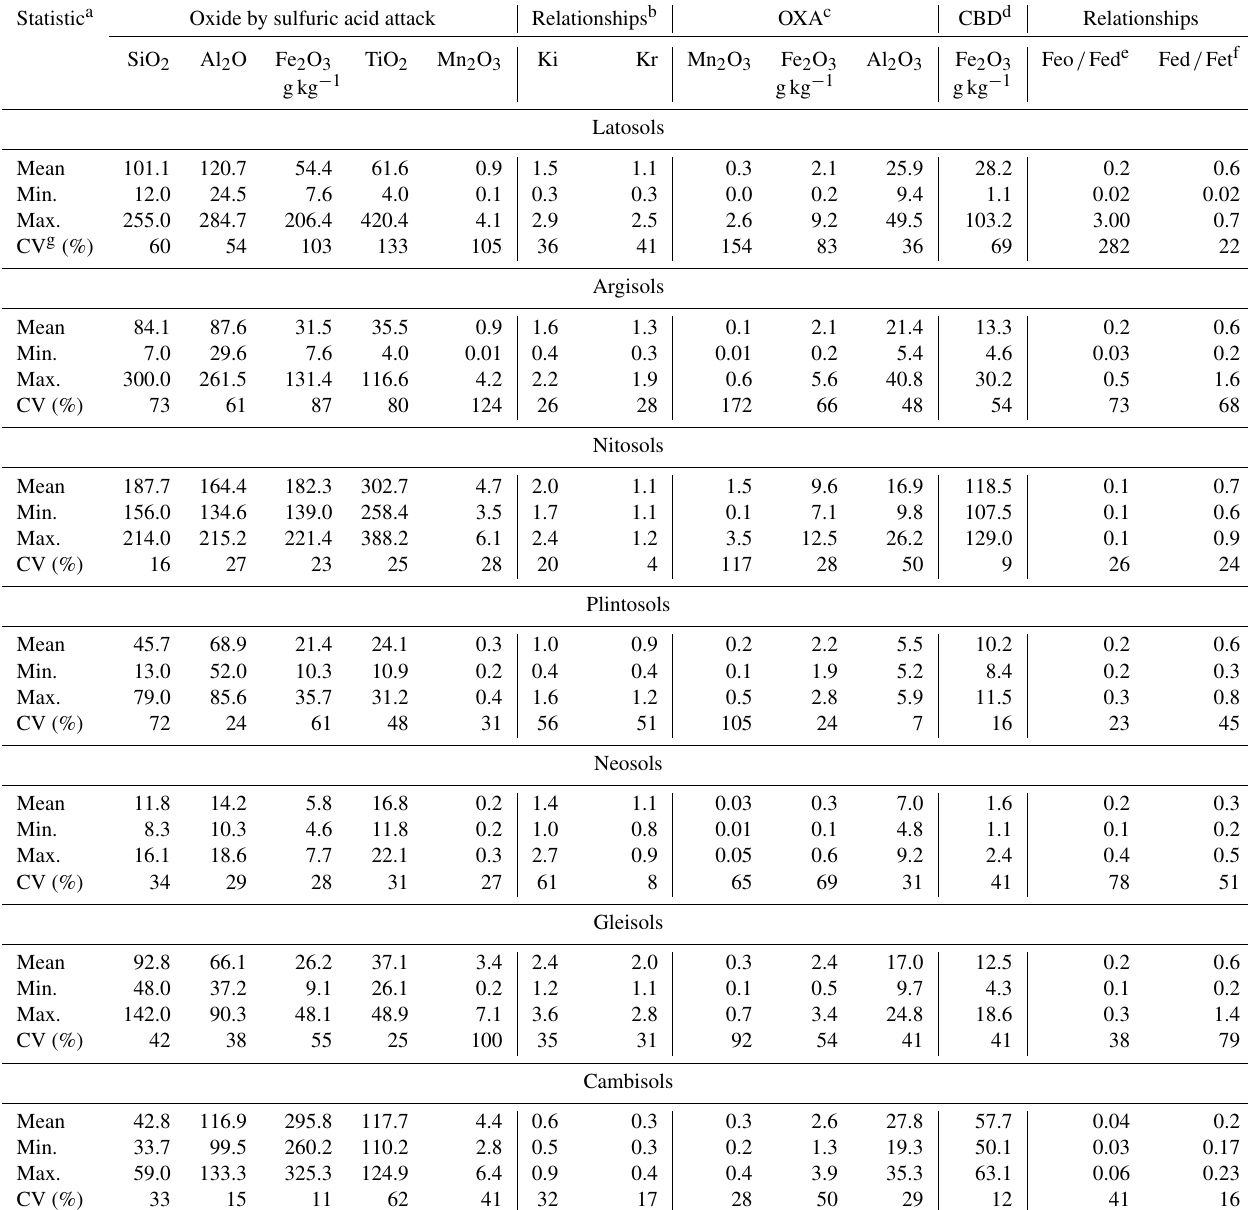
Table 2. Descriptive statistic of the levels of oxides SiO 2 , Fe 2 O 3 , Al 2 O 3 , Mn 2 O 3 , and TiO 2 extracted by alkaline and sulfuric acid attack, of the poorly crystallized forms of Mn 2 O 3 , Fe 2 O 3 , and free oxides Fe 2 O 3 , and the relationships between them in the soil surface layer in the state of